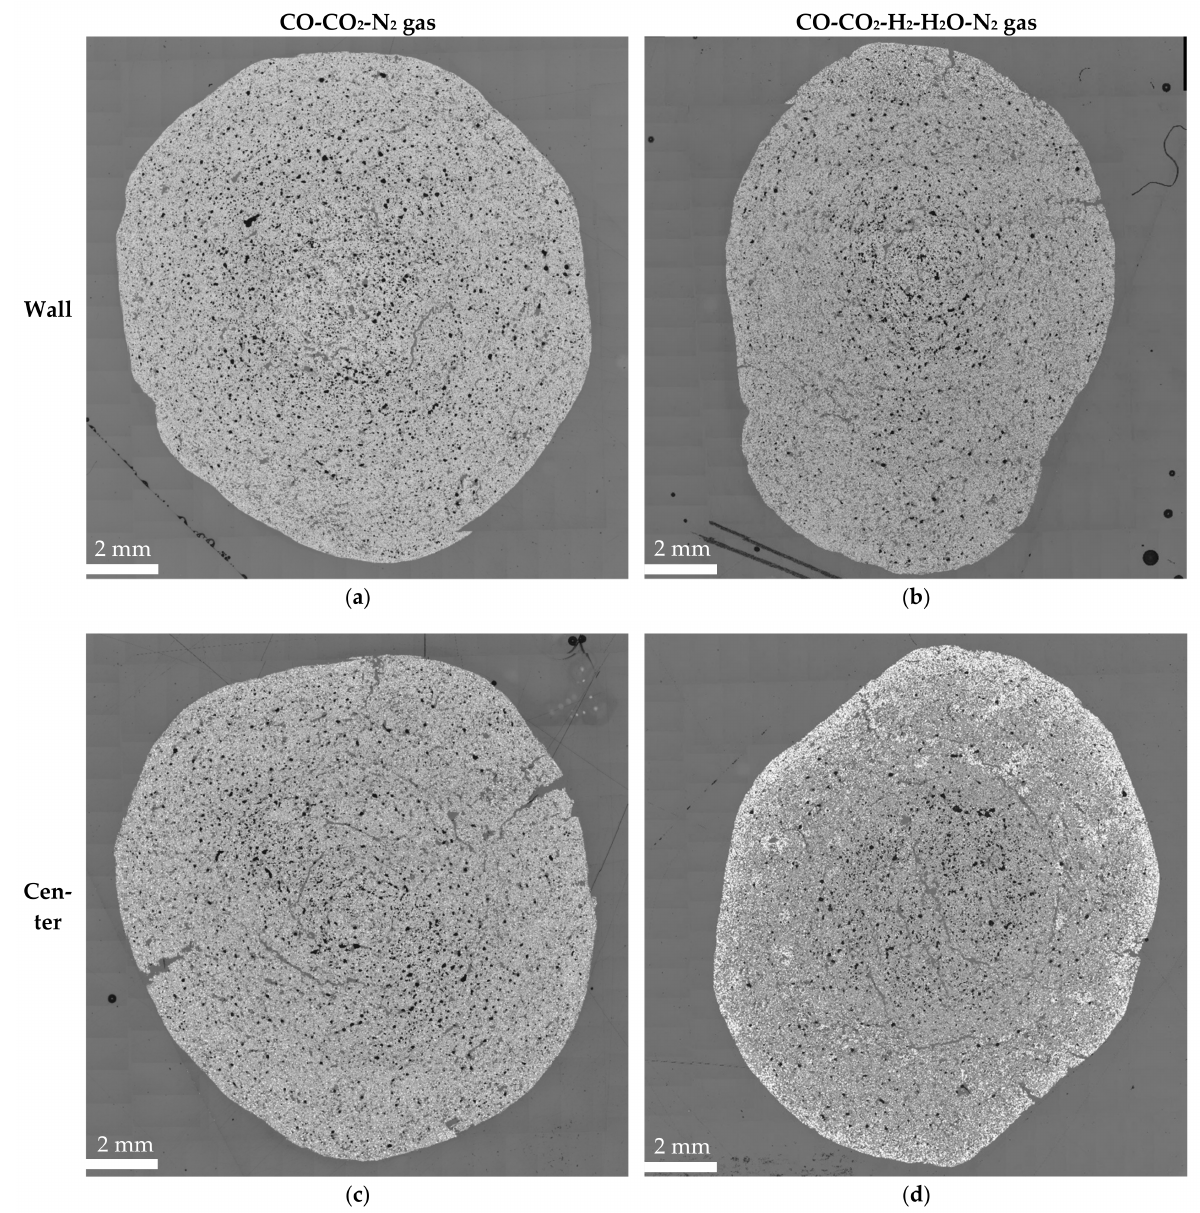
Figure 8. Pellet cross-sections after isothermal reduction at 800 ◦ C, using ( a ) the wall profile in CO-CO 2 -N 2 gas, ( b ) the wall profile in CO-CO 2 -H 2 -H 2 O-N 2 gas, ( c ) the center profile in CO-CO 2 -N 2 gas, and ( d ) the center profile in CO-CO 2 -H 2 -H 2 O-N 2